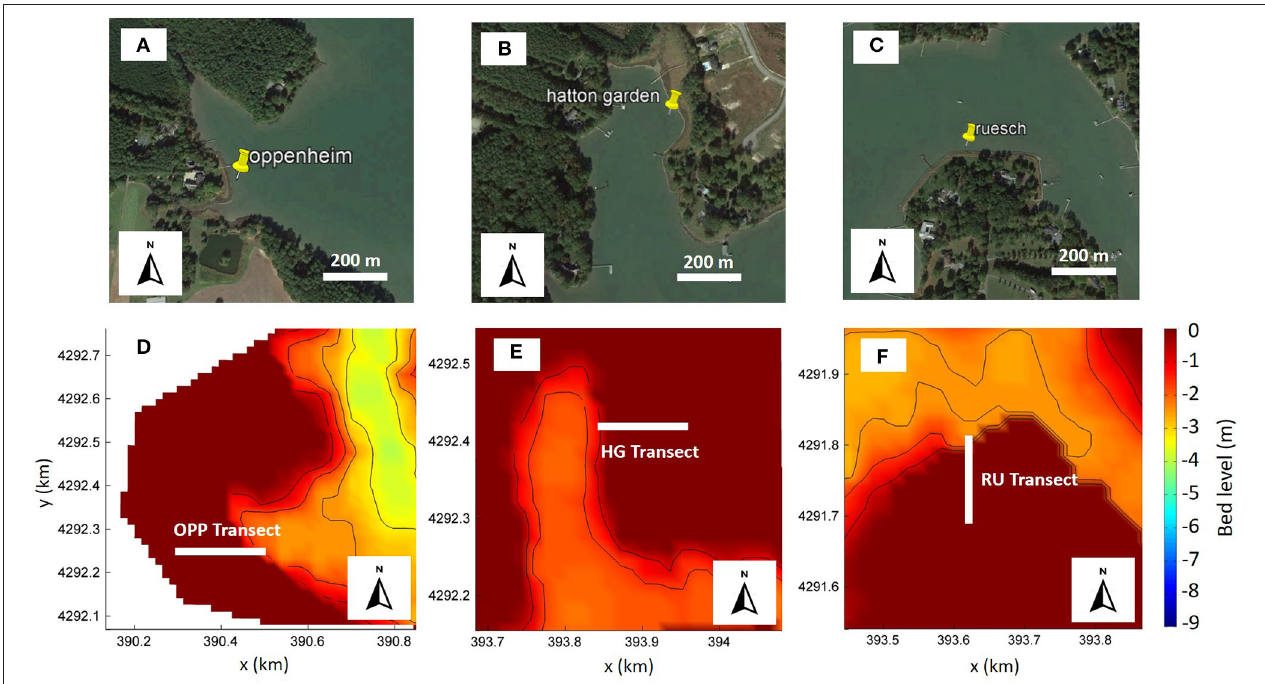
FIGURE 4 | Study sites with the respective transects considered in the model. (A) Oppenheim site with (D) the corresponding transect used in the model to validate the deposition rate. (B) Hatton garden with (E) the corresponding transect used in the model to validate the deposition rate. (C) Ruesch with (F) the corresponding transect used in the model to validate the deposition rate (Photo credits: Google